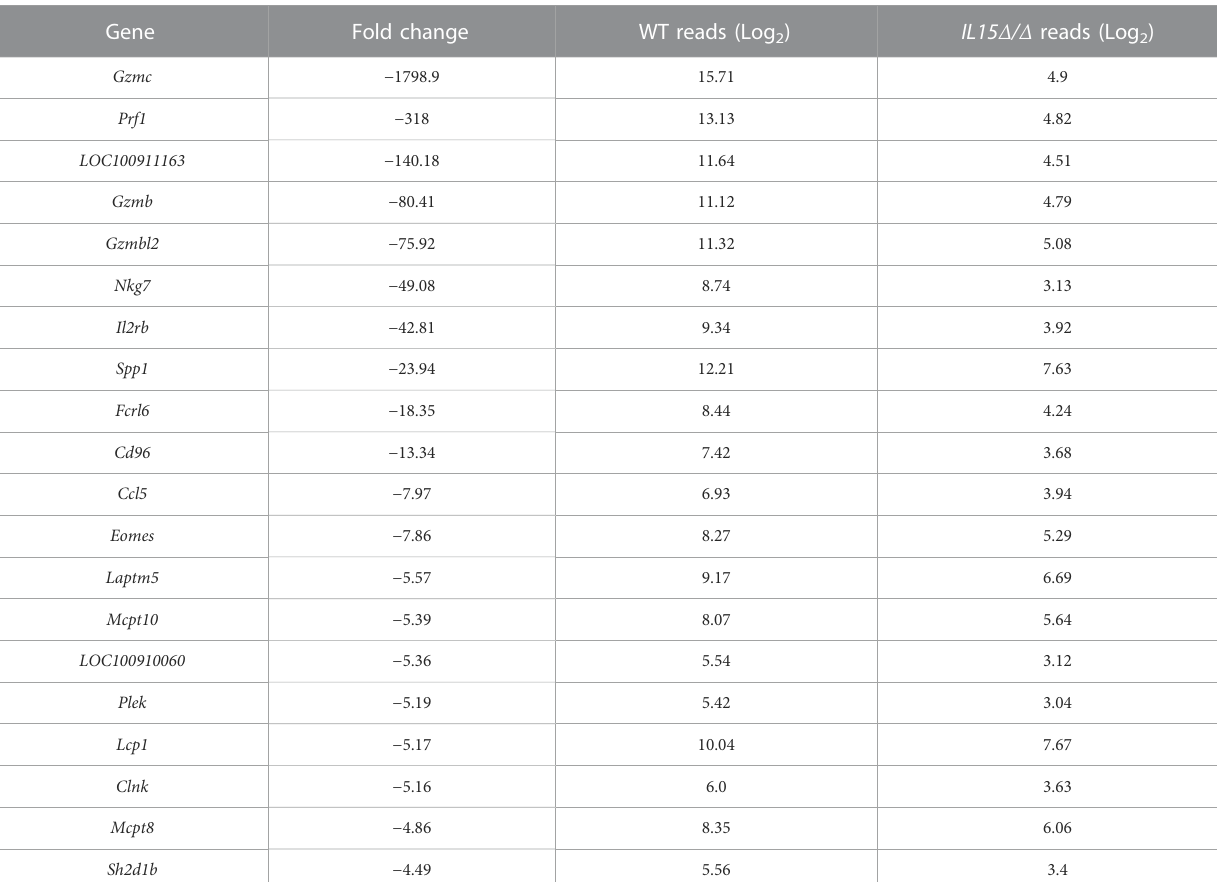
TABLE 3 List of top 20 downregulated genes in IL15 Δ / Δ rat conceptuses.